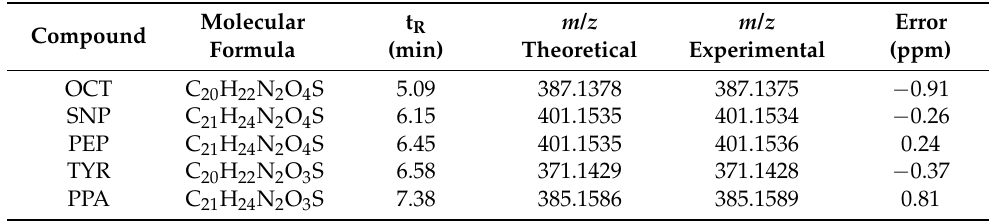
Table 1. UHPLC-Q-TOF-MS parameters of the studied